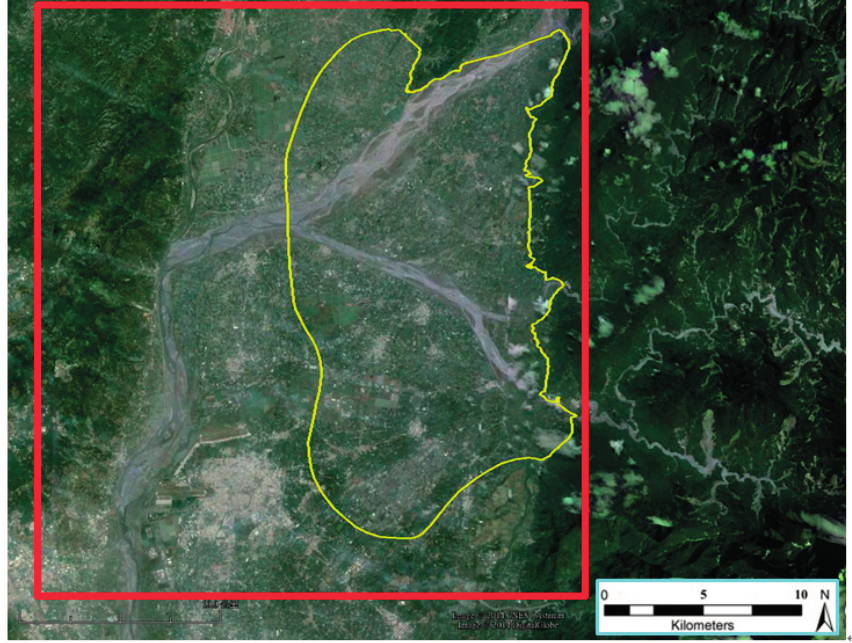
Figure 10. Experiment area at Pingtung Plain, Taiwan (background map courtesy of Google